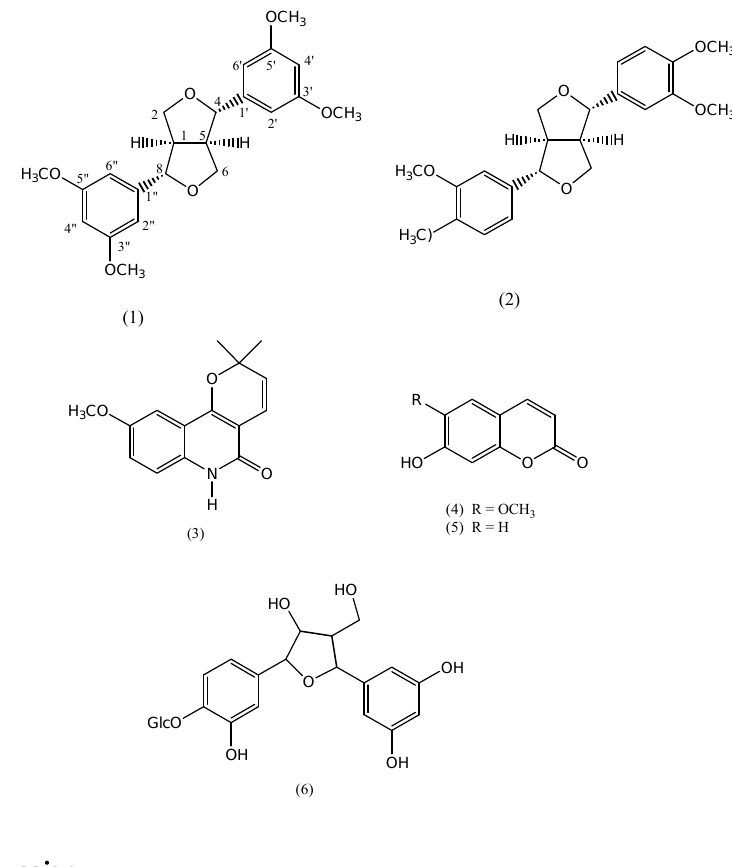
Figure 1. Compounds identified from H. villosum